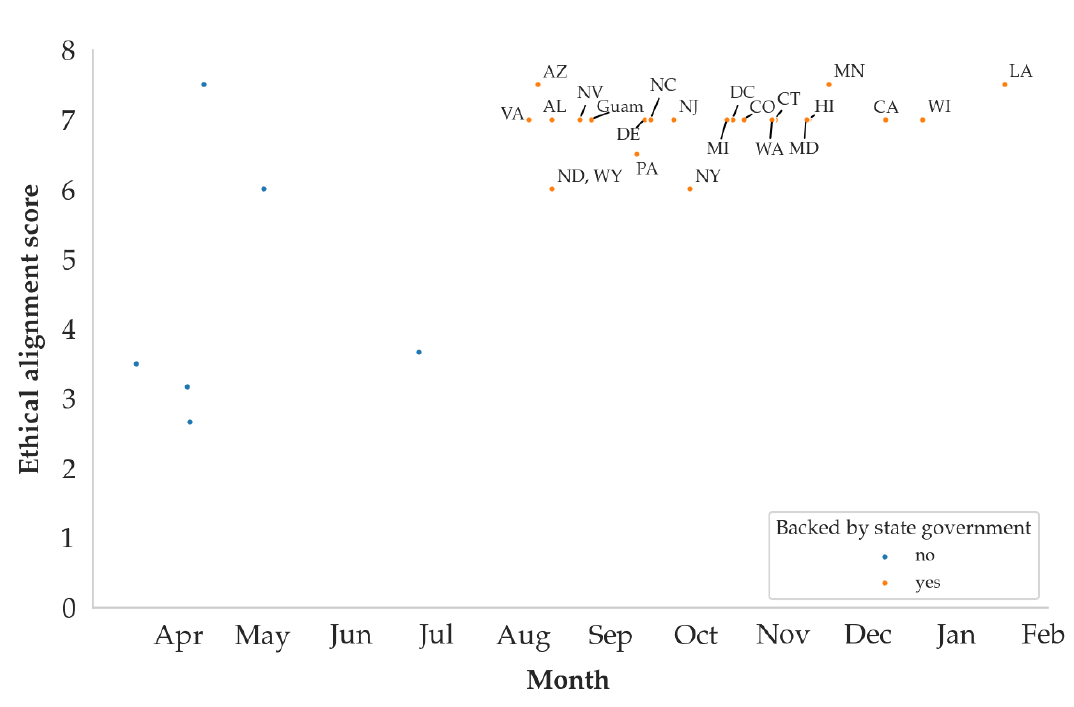
Figure 9. Ethical alignment scores vs. release date for contact tracing apps released in the United States. Color denotes government (orange) or nongovernment